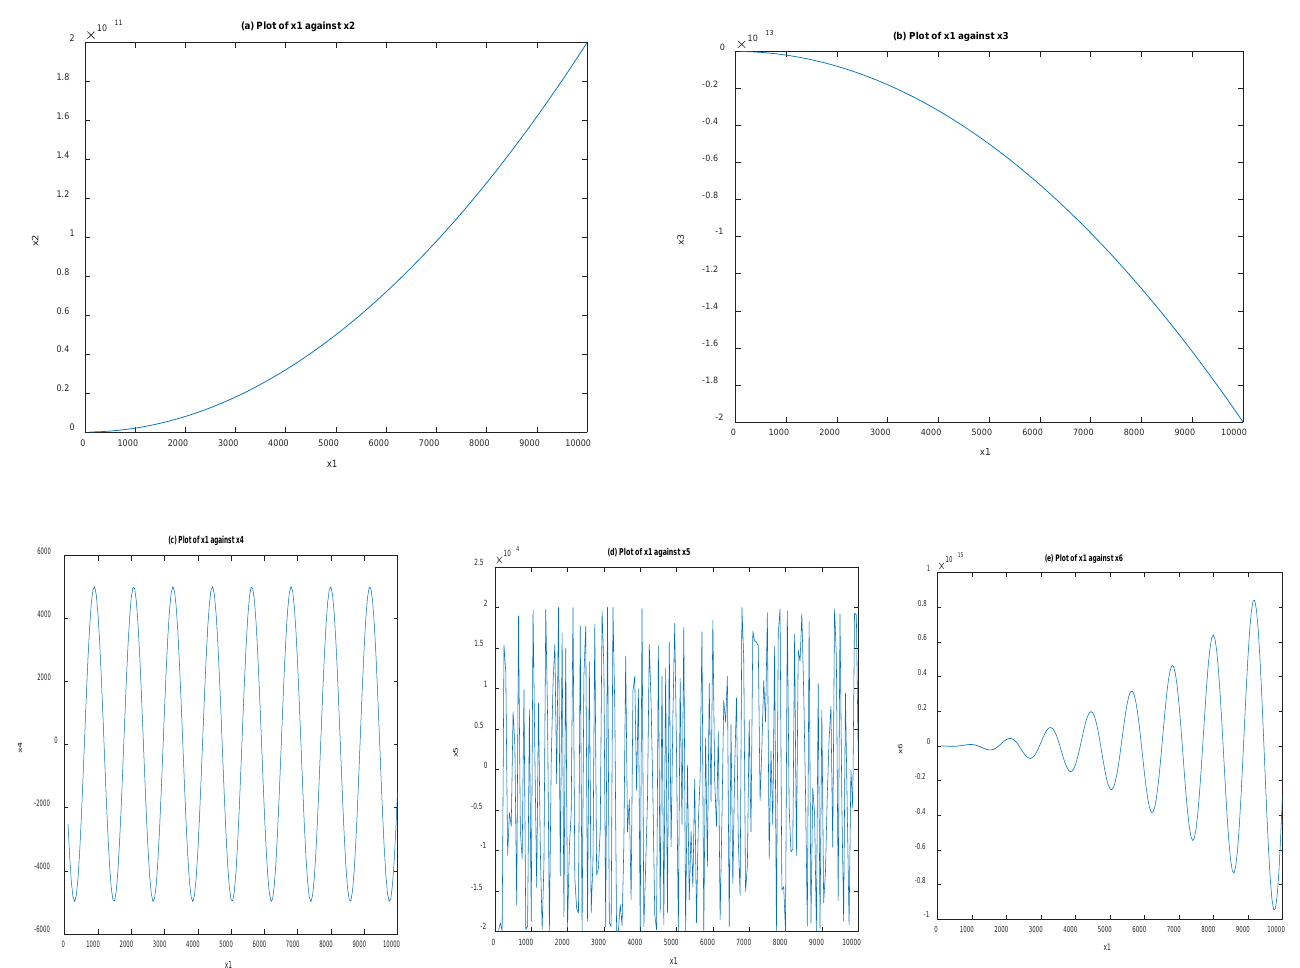
Figure 5. Simulation of the CB model of SoTE for x 1 = 1:0.5:100 with variation in v 1 and v 2 . ( a )input quadratic function, ( b ) input quadratic function, ( c ) resultant polynomial function, ( d ) induced interference ( e ) output wave function.